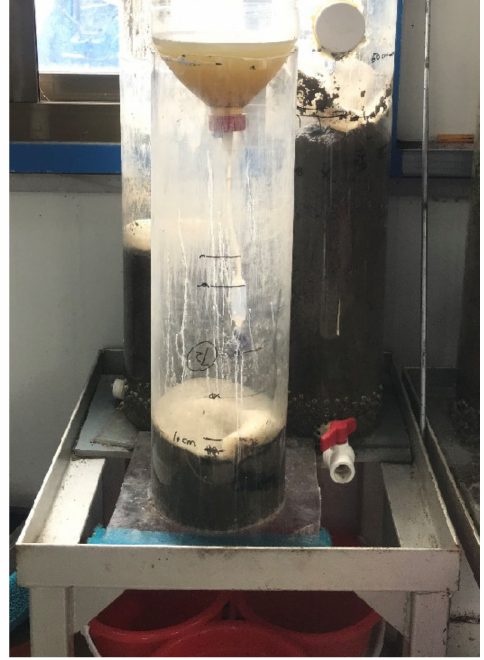
Figure 1. Photograph of soil column infiltration test.